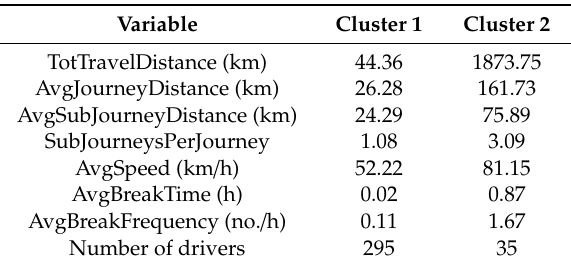
Table 1. Cluster